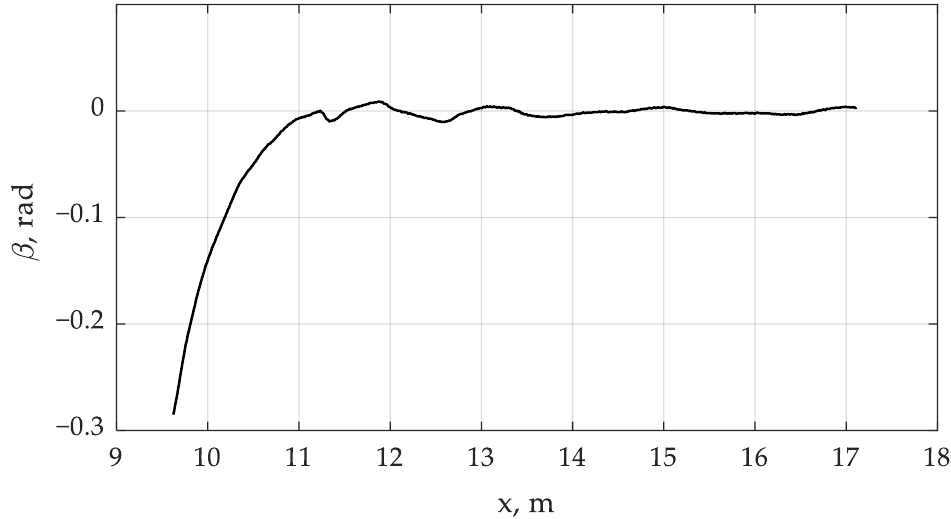
Figure 10. Course of the angles of deviation of the vehicle axis from the given direction of move- ment.